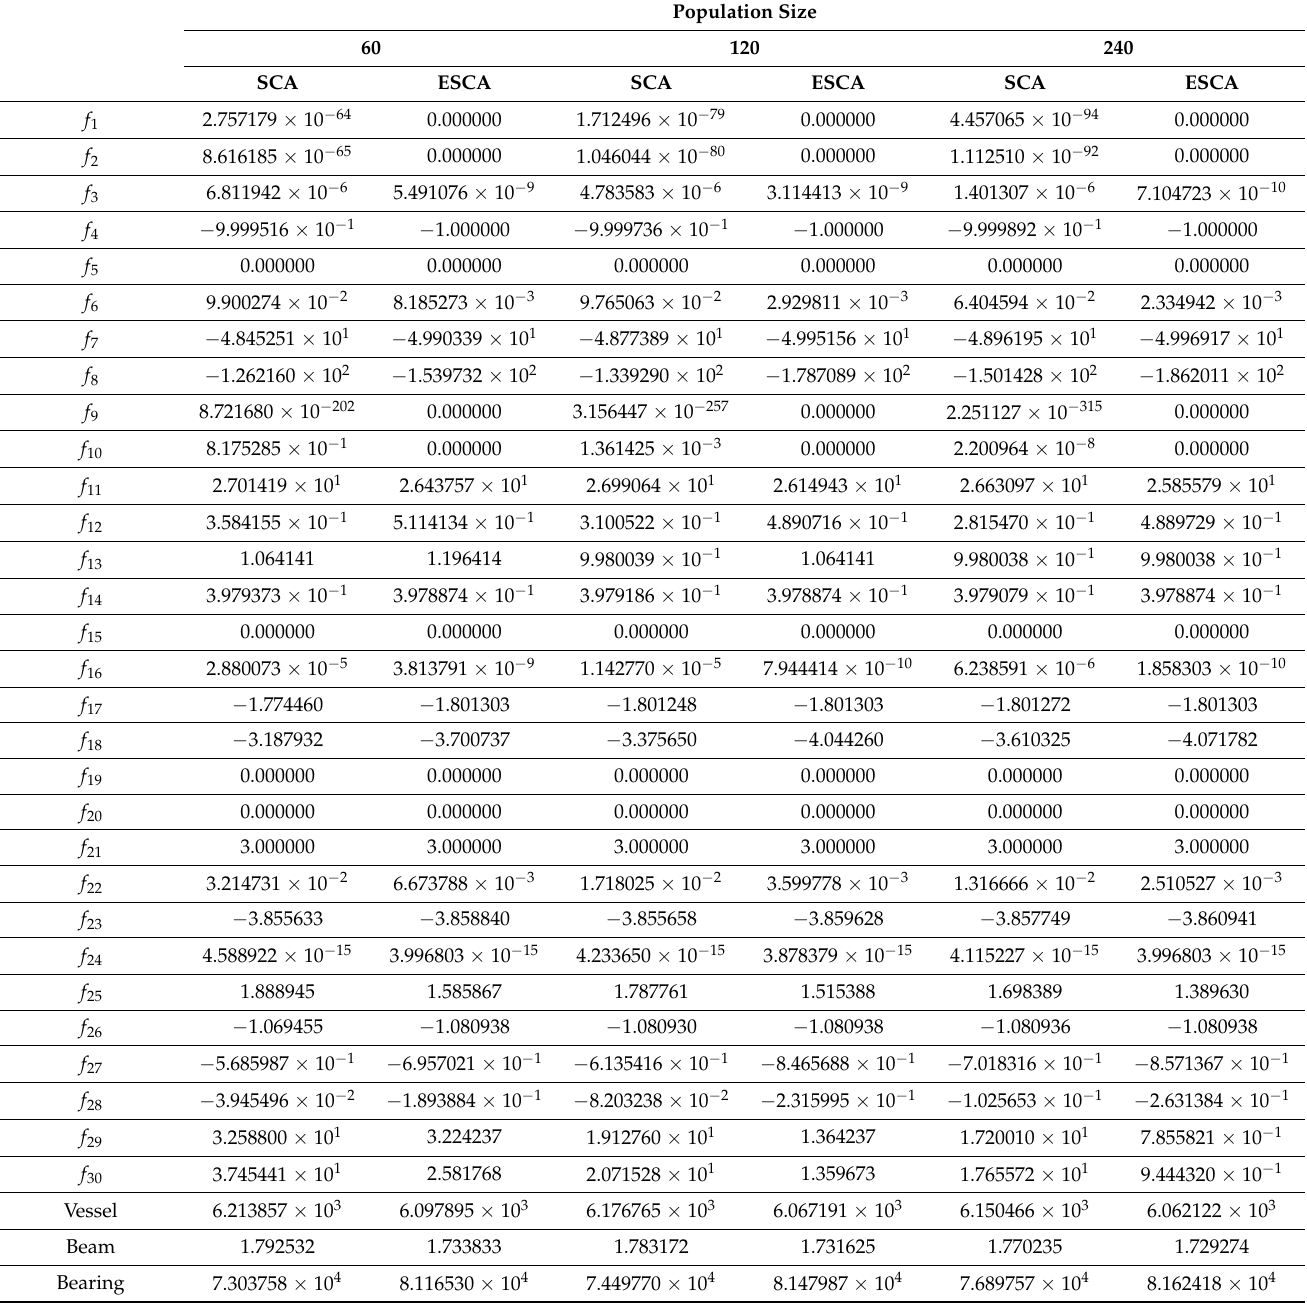
Table 15. Average values for unconstrained and constrained problems obtained by ESCA and